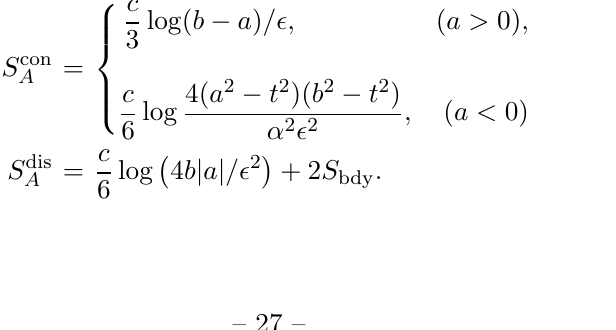
The middle graph shows a logarithmic growth at an early time. Indeed, from (5.4), we (cid:12)nd that when j a j (cid:28) t (cid:28) b , the EE shows the logarithmic